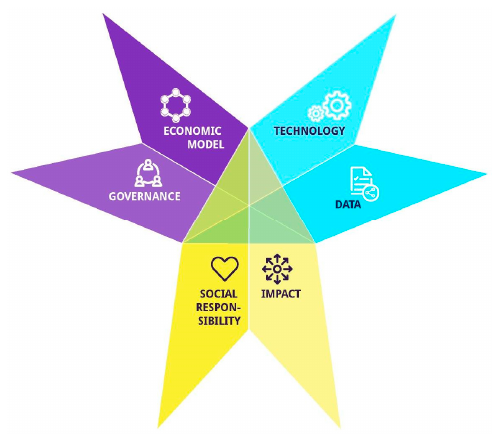
Figure 1. Procommons collaborative economy analytical star framework.